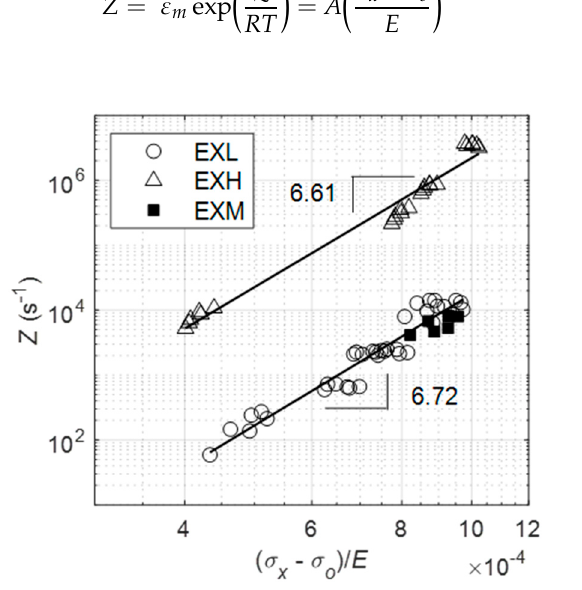
Figure 21. Plot of Zener–Hollomon parameters of EXL and EXH materials. A single stress state for EXM is included for comparison with EXL.